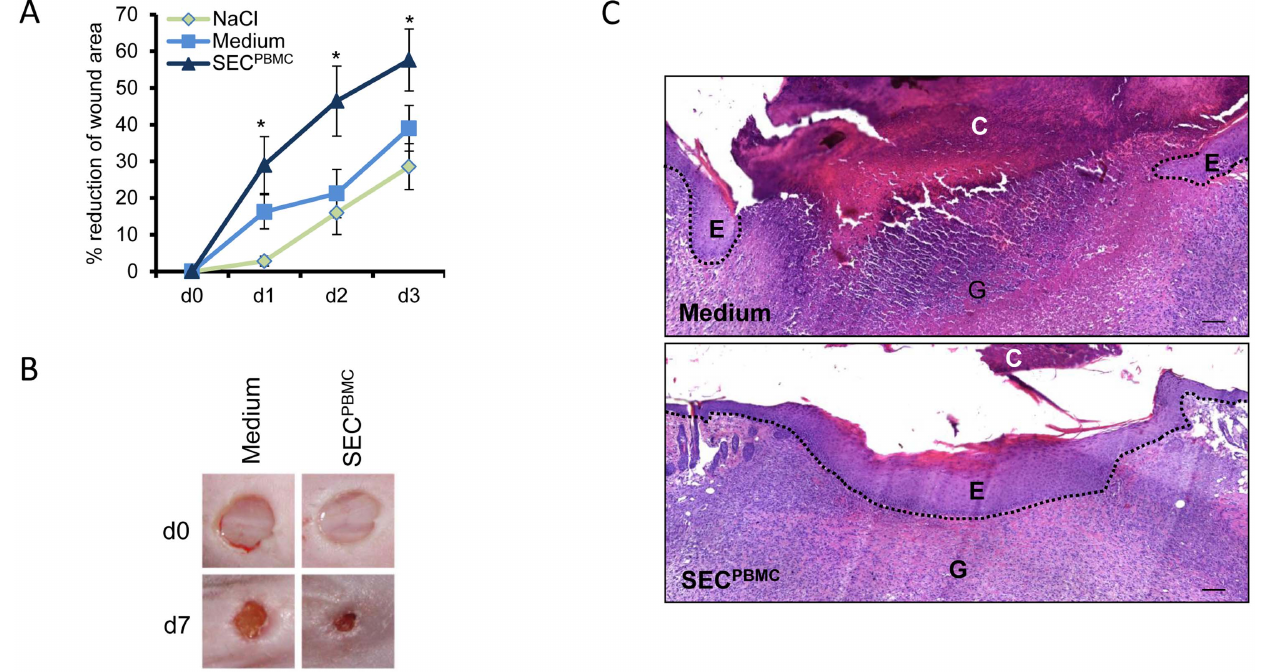
Figure 1. SEC PBMC leads to enhanced wound closure and re-epithelialization. ( A ) Wound areas were measured during the first 3 days after wounding. Treatment with SEC PBMC significantly enhanced wound closure. Error bars represent one standard deviation calculated from 15 animals for each set of values (*: p , 0.05). ( B ) Representative photographs from mouse wounds (n=15 from each group) immediately after wounding and at day 7 after wounding are shown. ( C ) H&E staining of wounds treated with medium or SEC PBMC 7 days after wounding is shown. While medium treated wounds still show a thick crust and little re-epithelialization, SEC PBMC treated wounds are fully re-epithelialized. C = crust, E = newly formed epidermis, G = granulation tissue. Scale bars: 100 m m. One representative animal of 15 is shown.